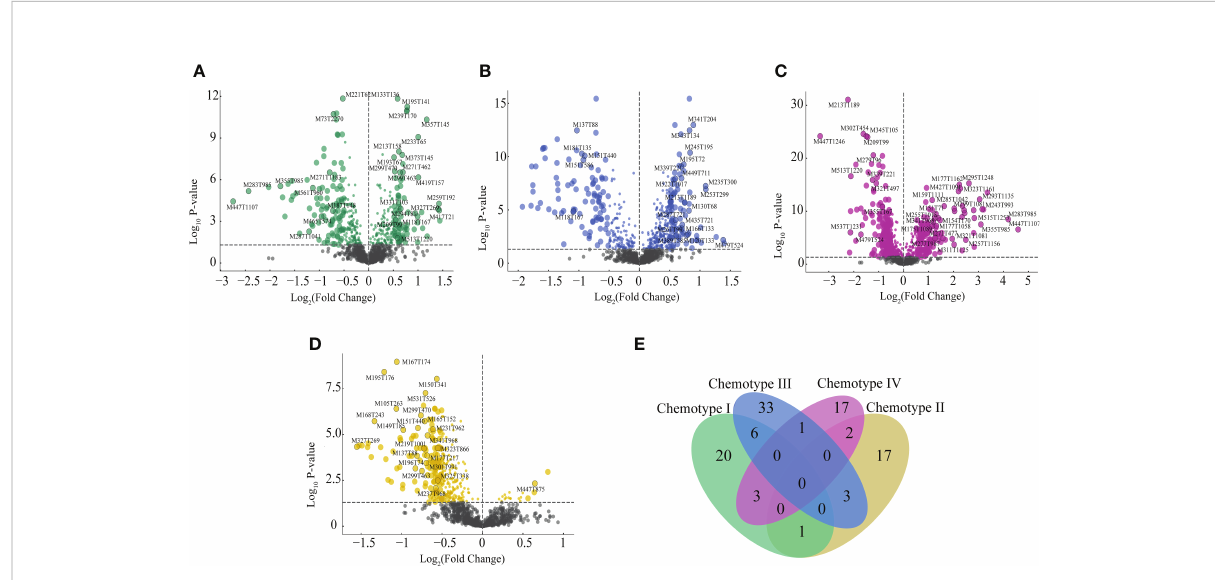
FIGURE 4 Screened chemomarkers of the four chemotypes. (A) Chemomarkers of chemotype (I) (B) Chemomarkers of chemotype II. (C) Chemomarkers of chemotype III. (D) Chemomarkers of chemotype IV. (E) Venn plot of the chemomarkers in four chemotypes.